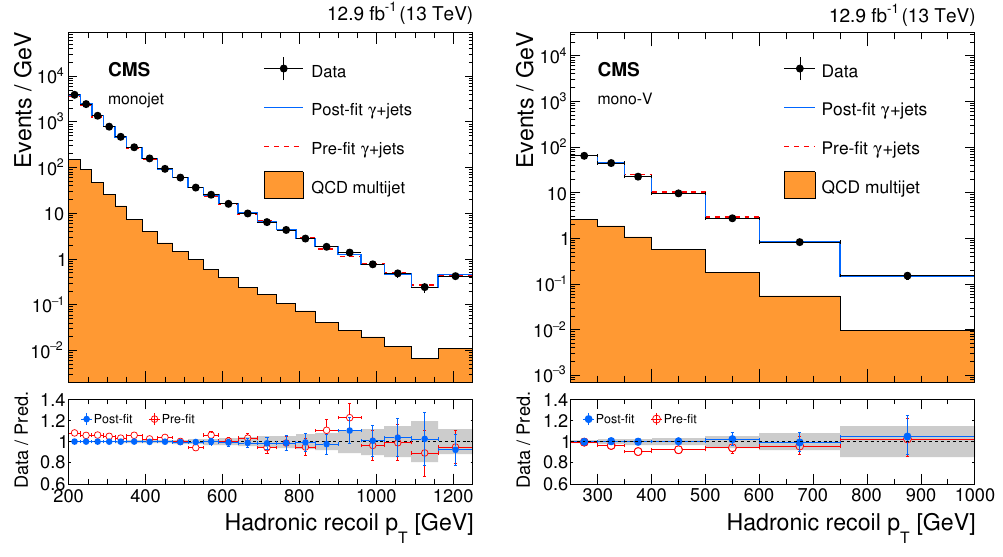
Figure 3 . Comparison between data and Monte Carlo simulation in the (cid:13) +jets control sample before and after performing the simultaneous (cid:12)t across all the control samples and the signal region, assuming the absence of any signal. The left plot shows the monojet category and the right plot shows the mono-V category. The hadronic recoil p T in (cid:13) +jets events is used as a proxy for E miss in the signal region. The (cid:12)lled histogram indicates the multijet background. Ratios of data and the pre-(cid:12)t background prediction (red points) and post-(cid:12)t background prediction (blue points) are shown for both the monojet and mono-V signal categories. The gray band indicates the overall post- (cid:12)t uncertainty. The last bin includes all events with hadronic recoil p T larger than 1160 (750) GeV in the monojet (mono-V)